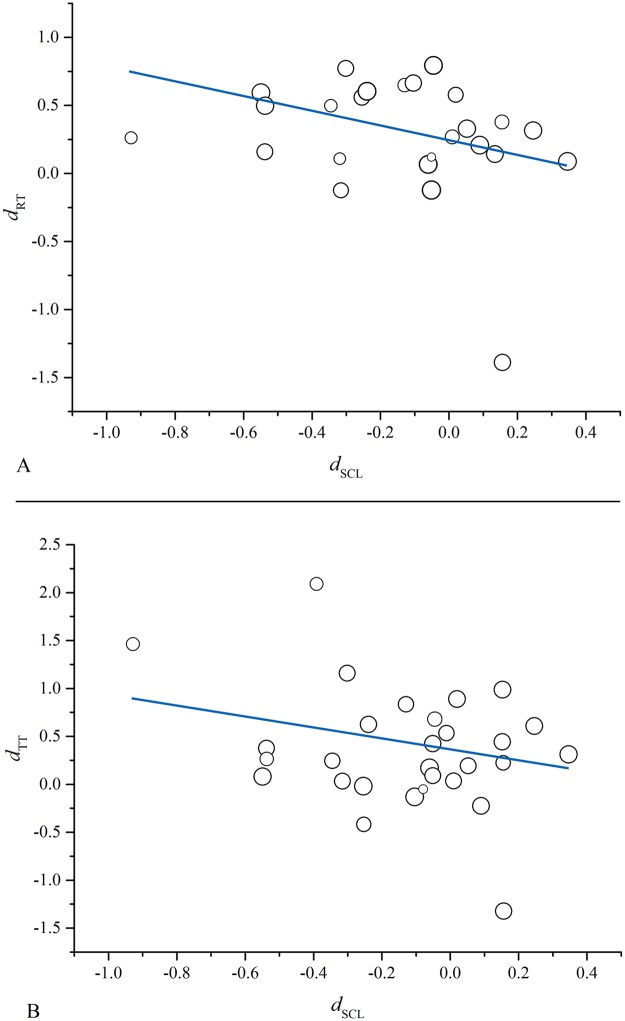
Retention-related and transfer-related meta-regression analyses.Note. (A) Regression of dSCL on dretention. (B) Regression of dSCL on dtransfer. Note. RT = retention test, TT = transfer test. The size of the circle is proportional to study weight.